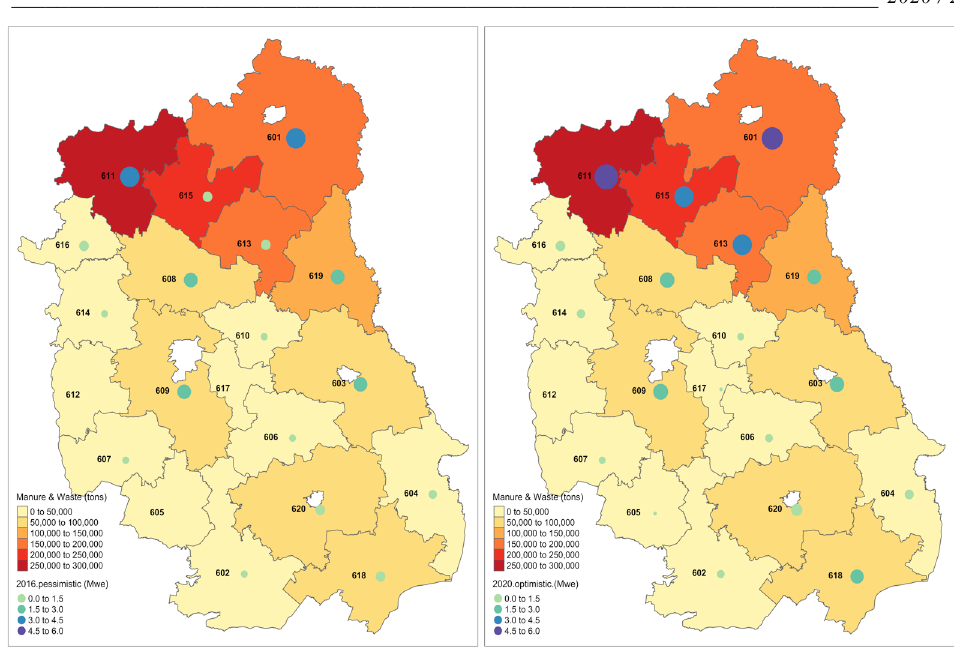
Fig. 2. Geo - location of installable power (MWe) in Lubelskie under 2016 (restrictive hypothesis, on the left) and 2020 (optimistic hypothesis, on the right) scenarios